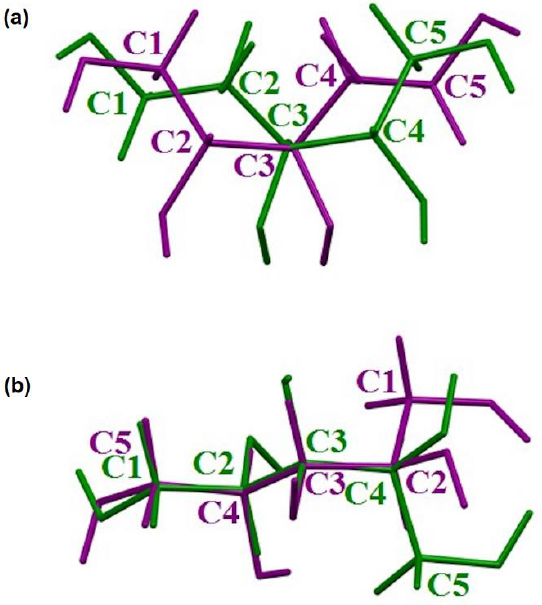
Figure 5. Overlay of both rotamers: ( a ) along C1 – C2 – C3 – C4 – C5 chains and ( b ) along C1 – C2 – C3 – C4 – C5 chain of one rotamer and reverse chain of second rotamer. Rotamers 1 and 2 are drawn as green and purple sticks, respectively.